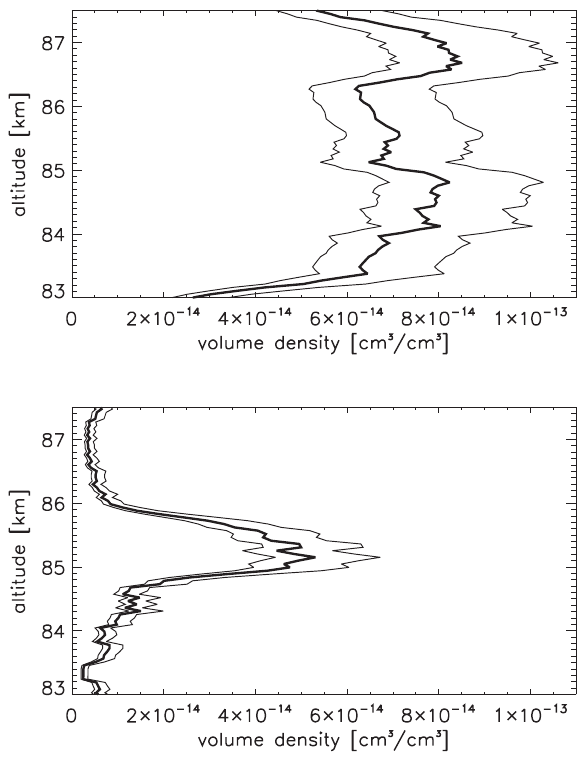
Fig. 9. Altitude profile of derived ice volume density (thick black line) with error bars (thin black lines). The upper panel shows re- sults from the upleg part of the rocket flight whereas the lower panel shows corresponding results from downleg. Note that the volume densities indicated here can be easily converted to mass densities by multiplying the given numbers by an ice density of 0.93g/cm 3 .